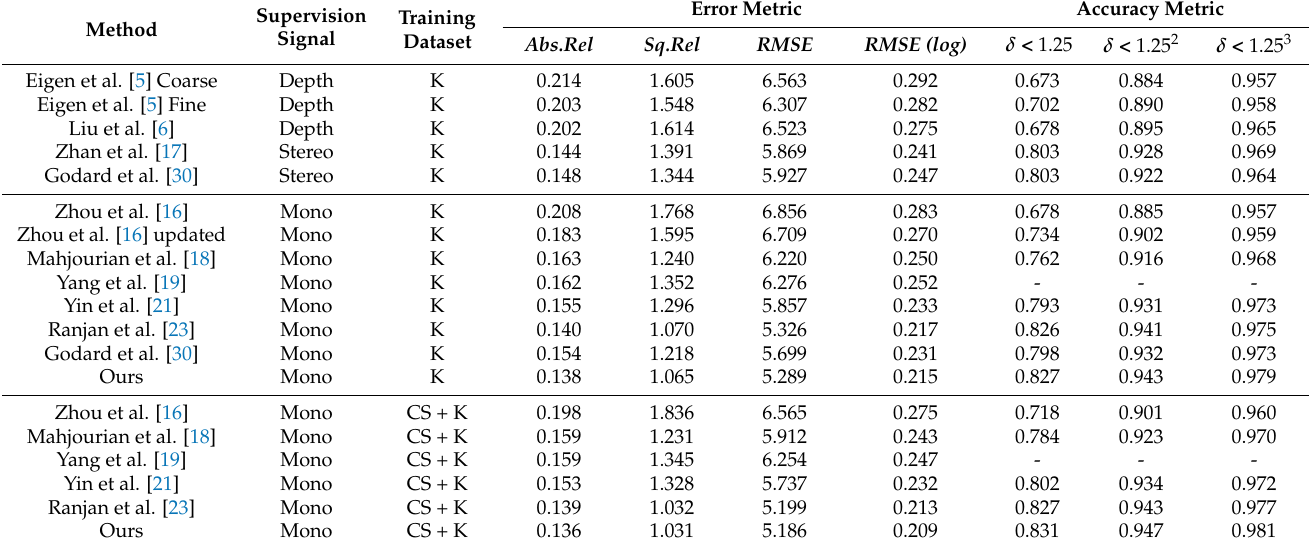
Table 3. Comparisons of different methods.